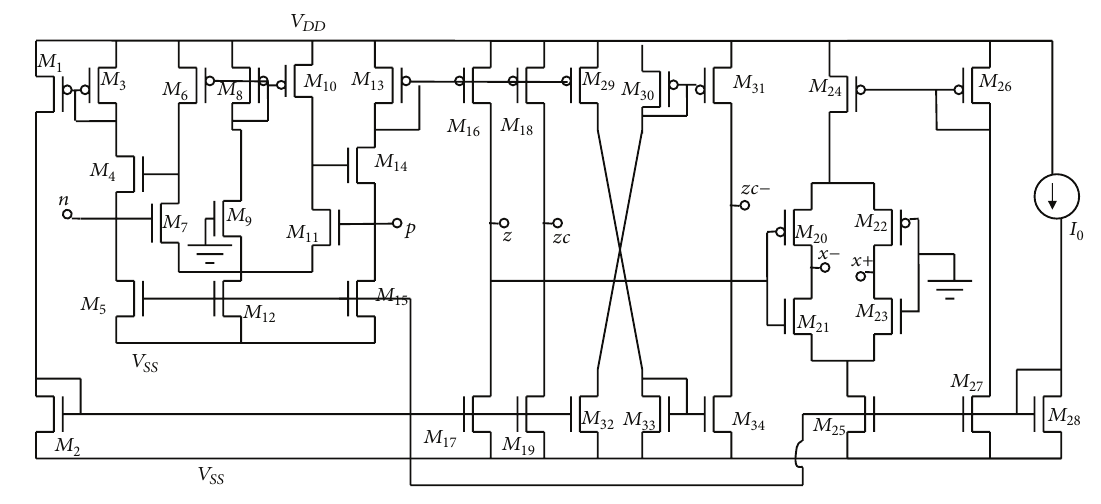
Figure 2: MZC-CDTA implementation.